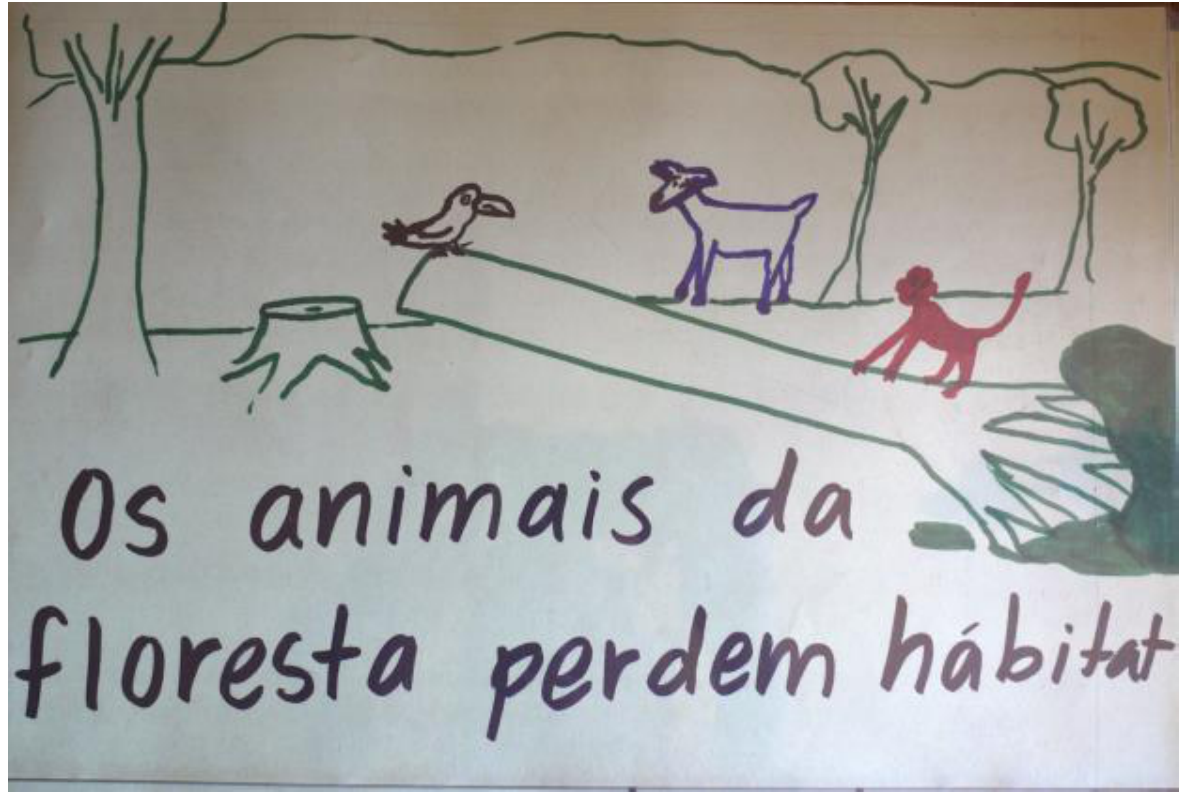
Fig. A1.2. One of eleven illustrations representing negative list items used in the rank order activity. This item depicts animal habitat loss. Interview participants ranked drawings like this one in order of concern (1 = most